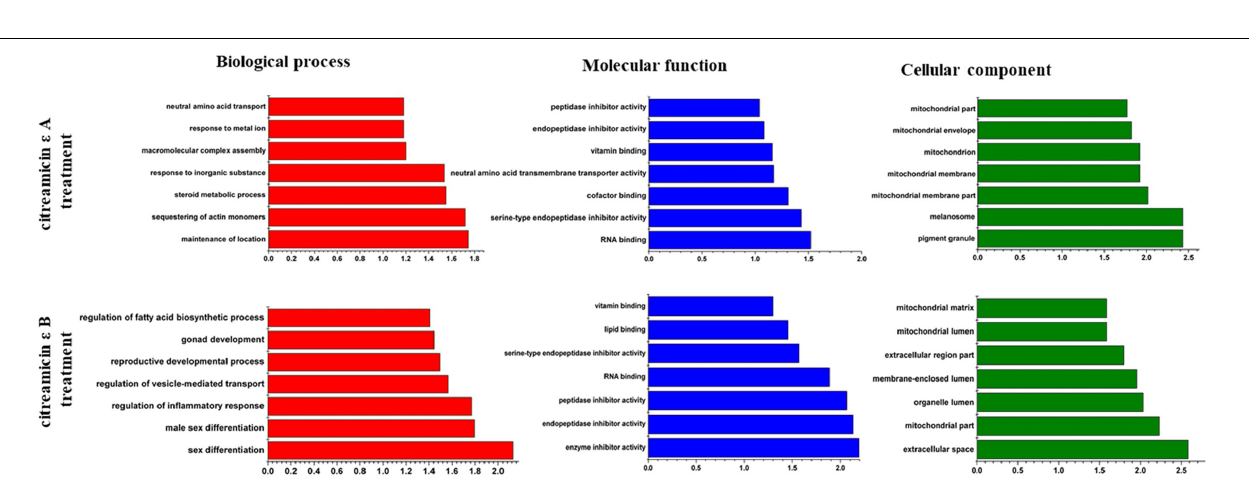
FIGURE 5 | Bioinformatics analysis of differentially expressed proteins (DEPs) in Ptk2 cells treated with citreamicin ε A and B for 24 h through Gene Ontology. The top 7 components for cellular component, biological process, and molecular function of the DEPs are presented along with their enrichment score represented as a P